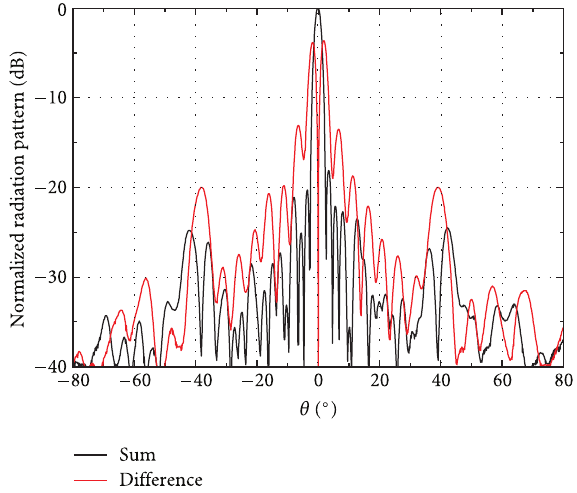
Figure 10: The radiation pattern of the monopulse circular- polarized DCWS antenna array at the center